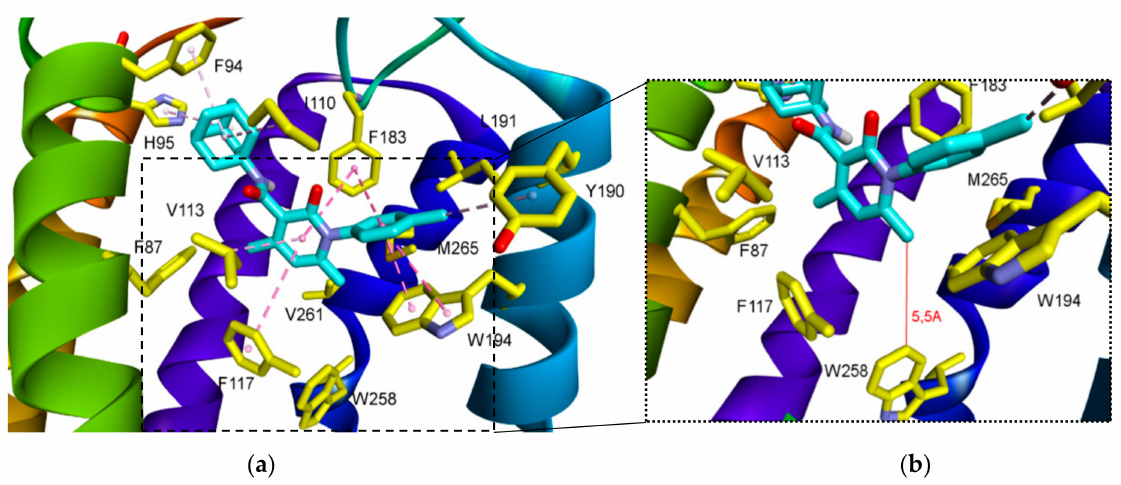
Figure 5. ( a ) Predicted binding mode of compound 8d in CB2R. Hydrophobic and π - π interactions are shown in dashed lines; ( b ) Distance between W258 residue and 8d